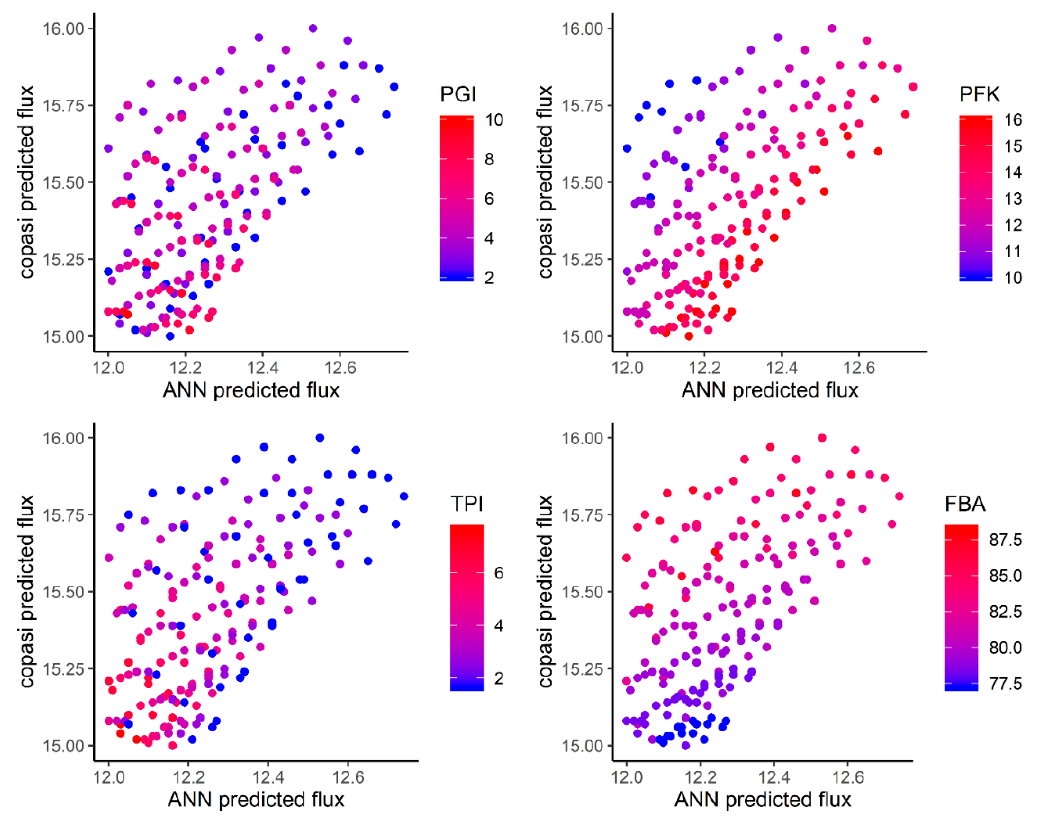
Figure 8. The relationship between flux values predicted by ANN vs COPASI for newly generated enzyme balances. The enzymes considered are: upper, left (PGI), right (PFK), lower left (TPI), right (FBA). The color gradient from blue to red represents the particular enzyme concentration from low to high, respectively.